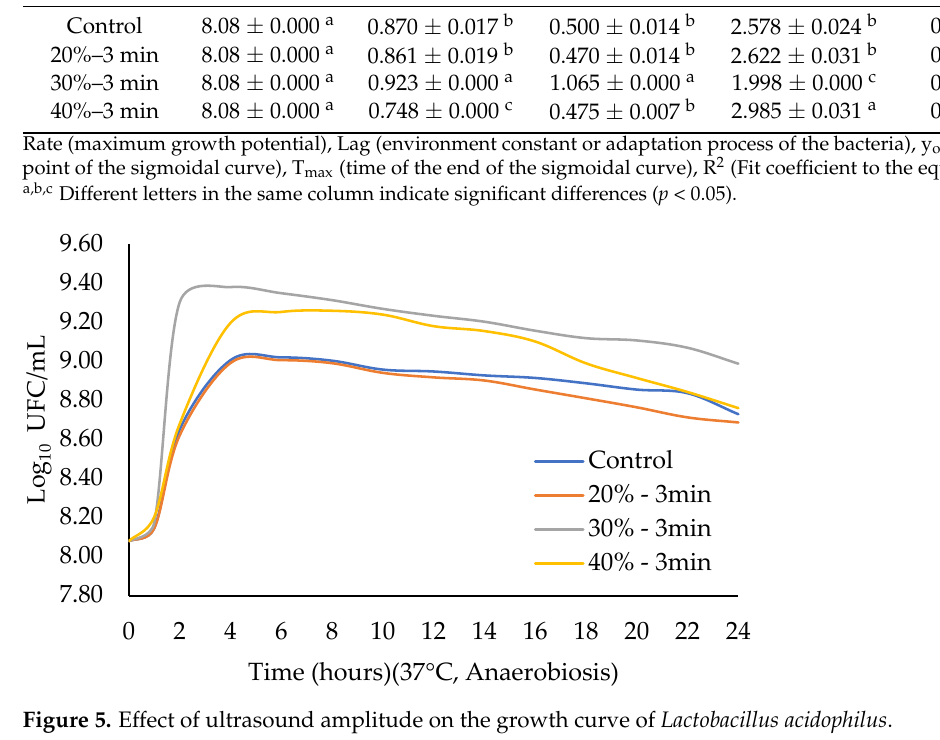
Figure 6. Effect of ultrasound amplitude on the pH kinetic of Lactobacillus acidophilus.